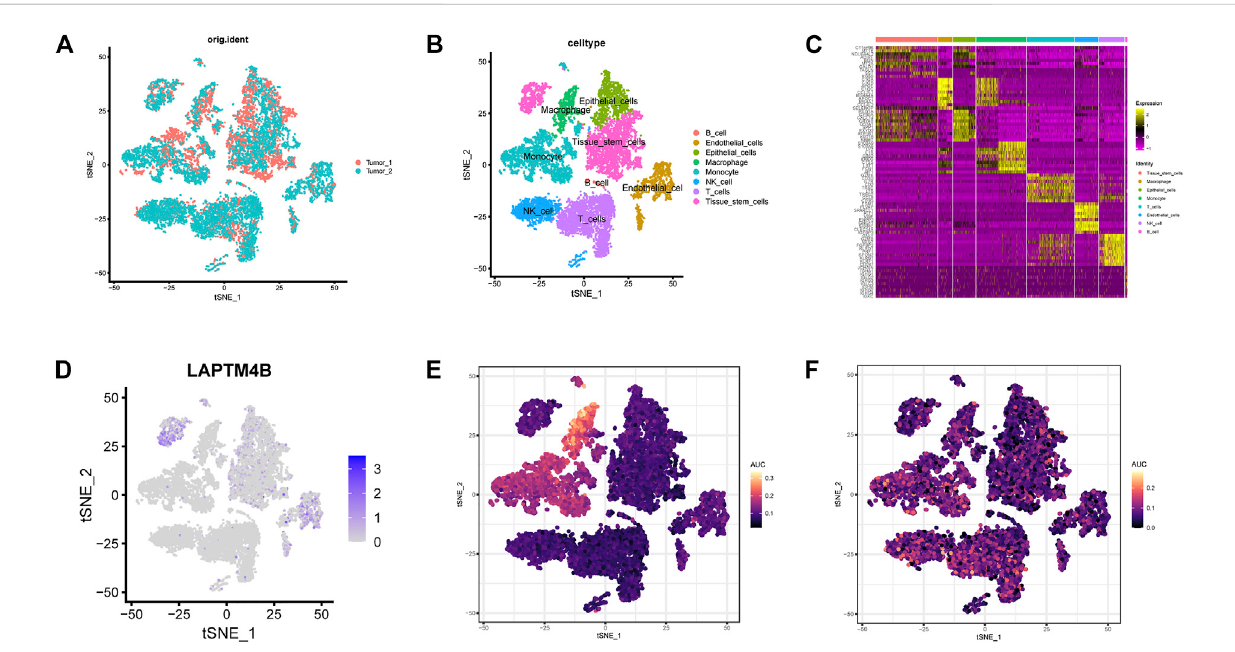
FIGURE 6 Evaluation of single cell pathway activity. (A) The tSNE diagram shows the results of integrating two ccRCC single-cell data using the harmony method. (B) ThesampleswereannotatedusingtheSingleRmethod,and8 celltypeswereobtained. (C) Theheatmapshowsthemarkgenesforthe8 cell types. (D) Expression of LAPTM4B in eight celltypes. (E) Lysosomal pathway activity in each celltypes. (F) Autophagy pathway activity in each